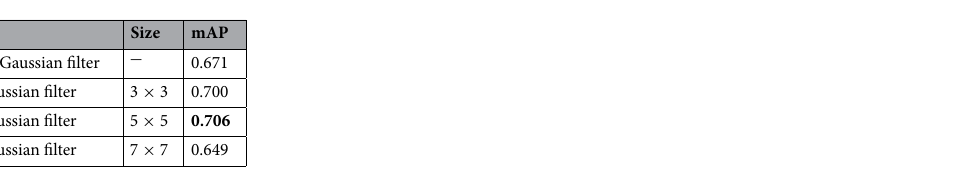
Table 2. Performance of the Swin transformer under various Gaussian filter parameters. The best result is in bold.